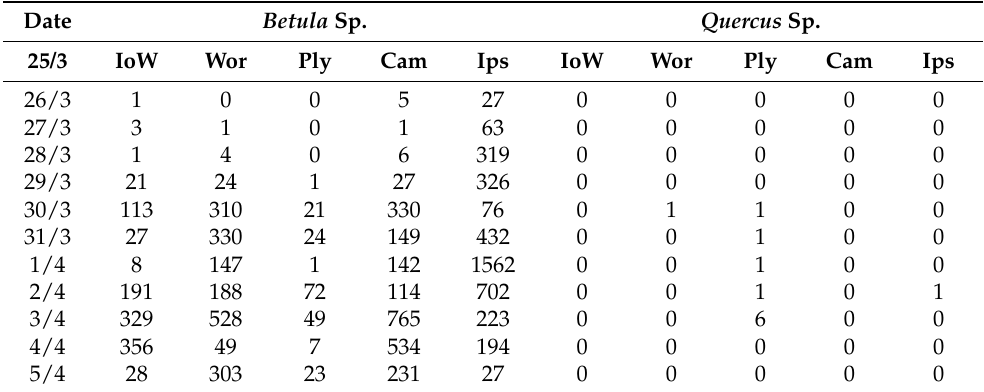
Table 1. Observed pollen concentrations in 2014 at the Isle of Wight (IoW), Worcester (Wor), Plymouth (Ply), Cambridge (Cam) and Ipswich (Ips) for Betula (birch) and Quercus (oak). Date Betula Sp. Quercus Sp. 25/3 IoW Wor